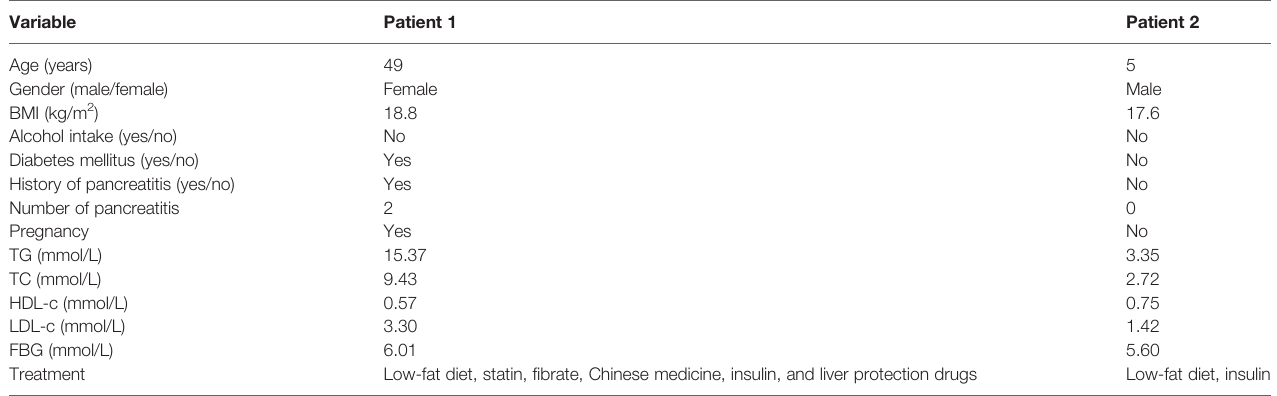
TABLE 1 | Clinical features and lipoprotein pro fi le of the individuals screened for LPL variants. Variable